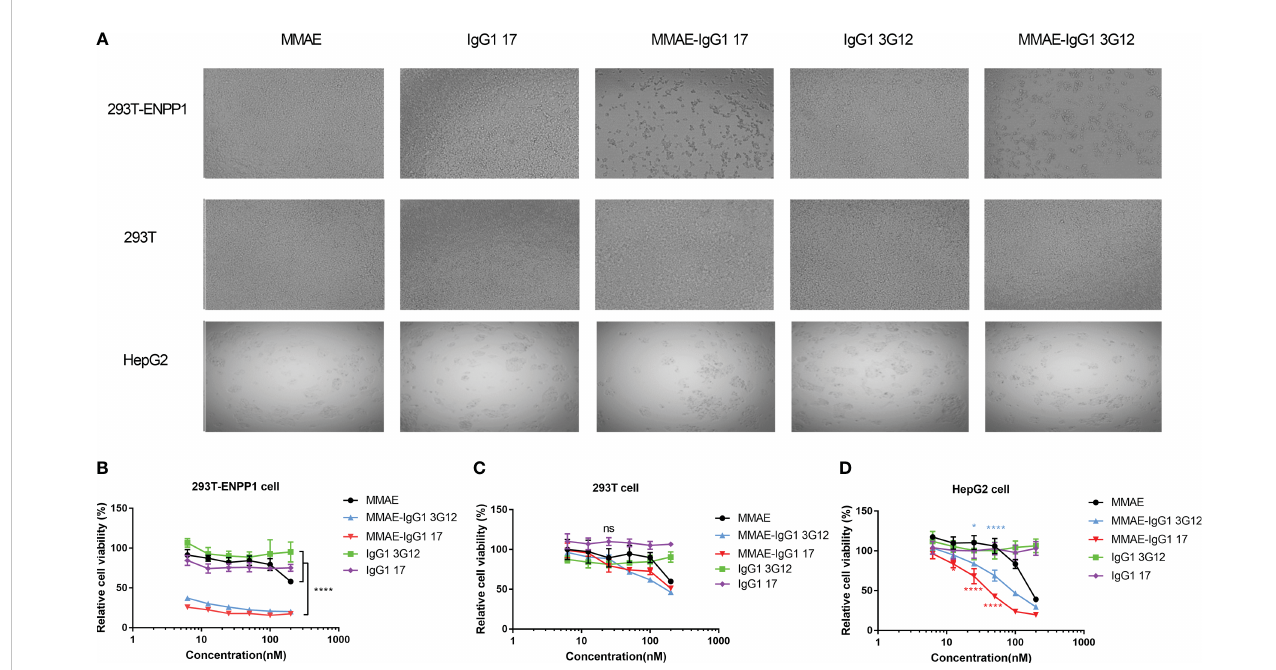
FIGURE 3 Cytotoxicity of IgG1-MMAE to ENPP1- expressing cells (A) , Representative pictures of ADC cytotoxicity, MMAE drug alone or IgG1 alone at 50nM on 293T-ENPP1 cell, 293T cell and HepG2 cell separately. Cells were plated into a 96-well plate and treated with MMAE-IgG1 or IgG1 and MMAE alone at different concentrations for 4 days. B-D, % Relative cell viability of 293T-ENPP1 cells (B) , 293T cells (C) , and HepG2 cells (D) after treatment with MMAE, IgG1 17/3G12 and MMAE-IgG1 17/3G12 separately. Replicates were performed in duplicate. Values are reported as the mean of percent relative cell viability ± SD. Experiments were repeated three times. Signi fi cance was tested using two-way ANOVA, followed by Tukey ’ s multiple comparisons test. ****, p <0.0001, *, p <